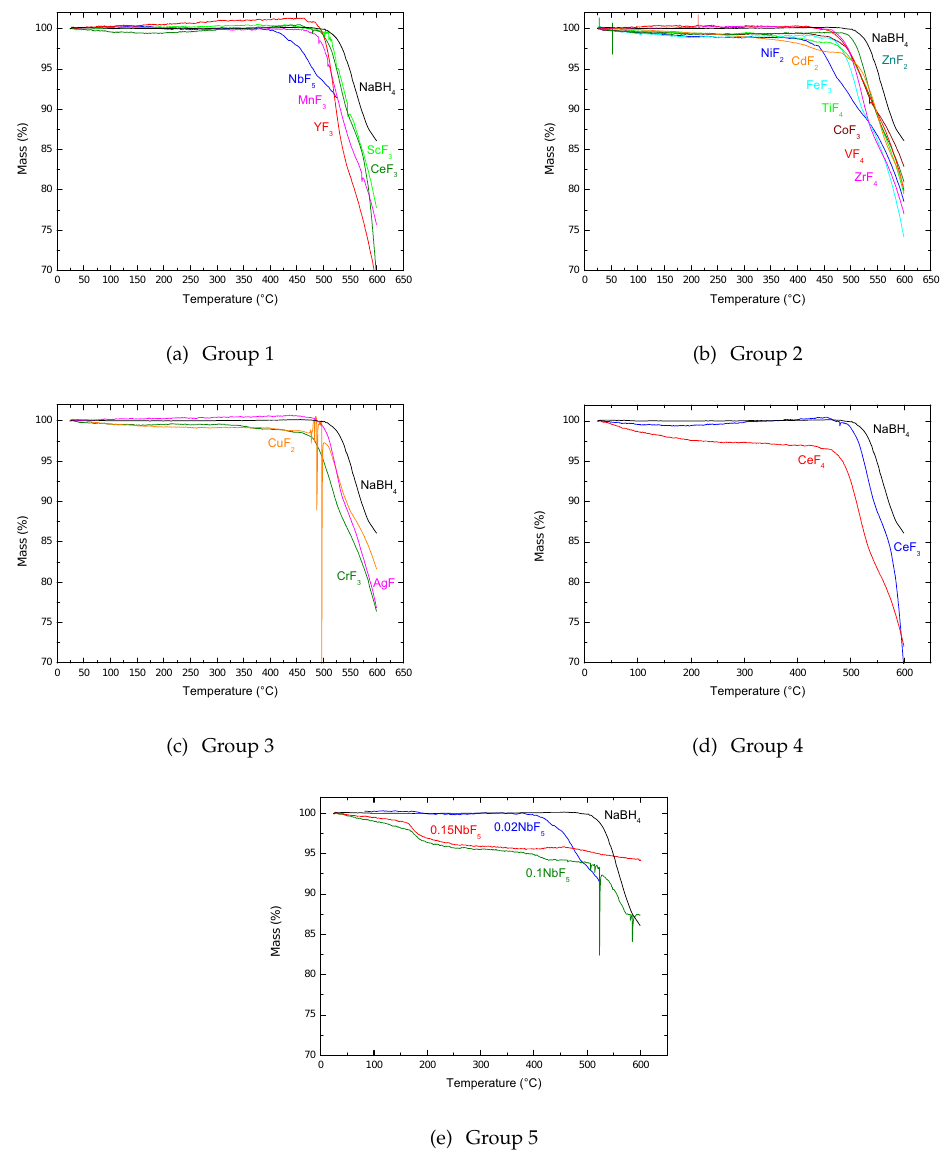
Figure A2. TGA corresponding to the samples distributed in the different groups discussed in the